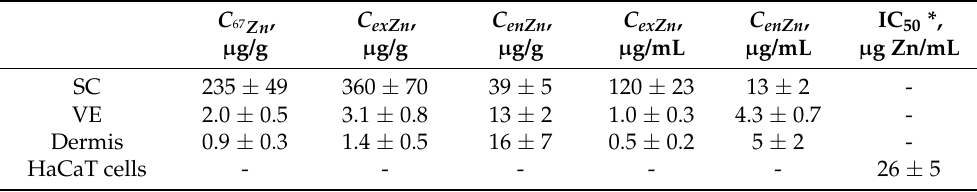
Table 1. Summary of the measured and calculated zinc values in human